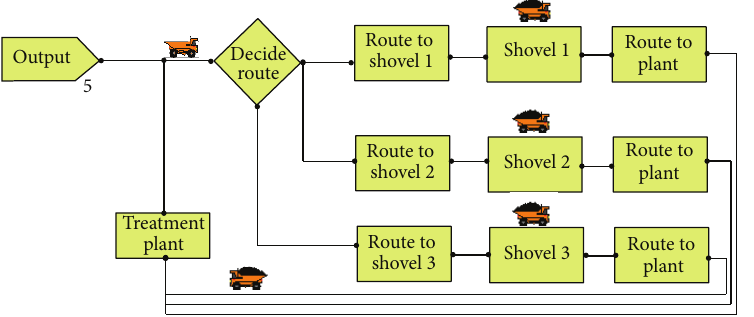
Figure 2: Limestone quarry simulation.